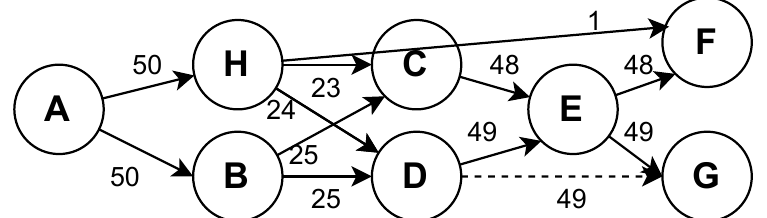
Figure 3. An example directly-follows